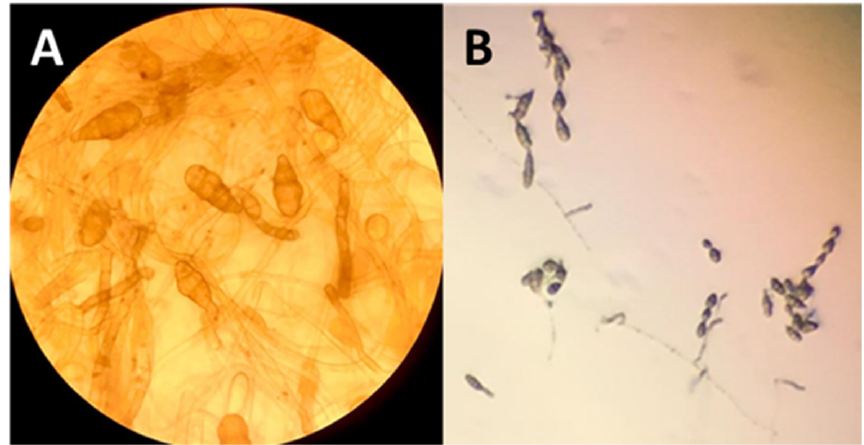
Figure 6. Morphology of Alternaria spp. isolated from roots. ( A ) Conidia and ( B ) conidial chains of Alternaria spp.